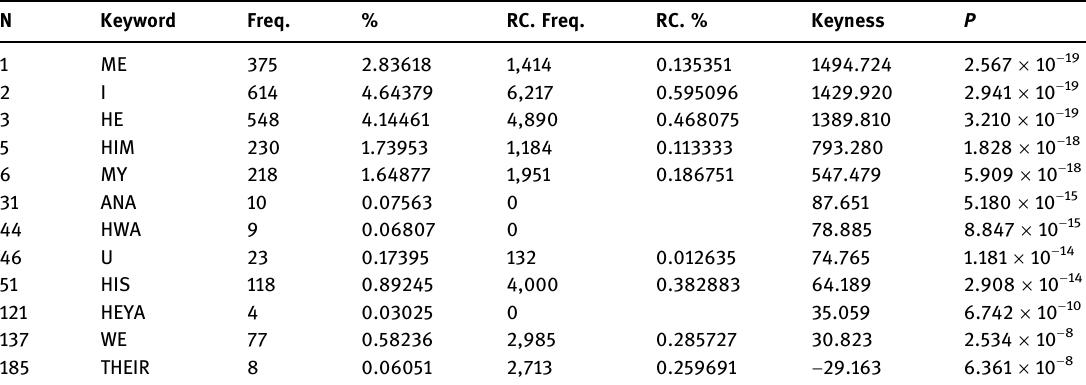
Table 3: Pronouns in the keyword